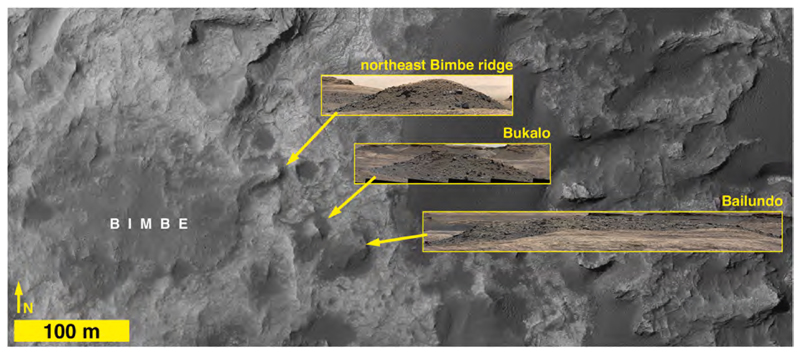
A ridge on the northeast side of Bimbe, which trends northeast-southwest (azimuth ~65.5°), is mantled with cobbles and small boulders in Mastcam images (inset). The ridge resembles nearby boulder- and cobble-mantled hills named Bukalo and Bailundo (insets). These are likely examples of buttes that have weathered to the point that they are hills with remnants of the capping rock taking the form of small boulders and cobbles (cf. Migon et al., 2018).